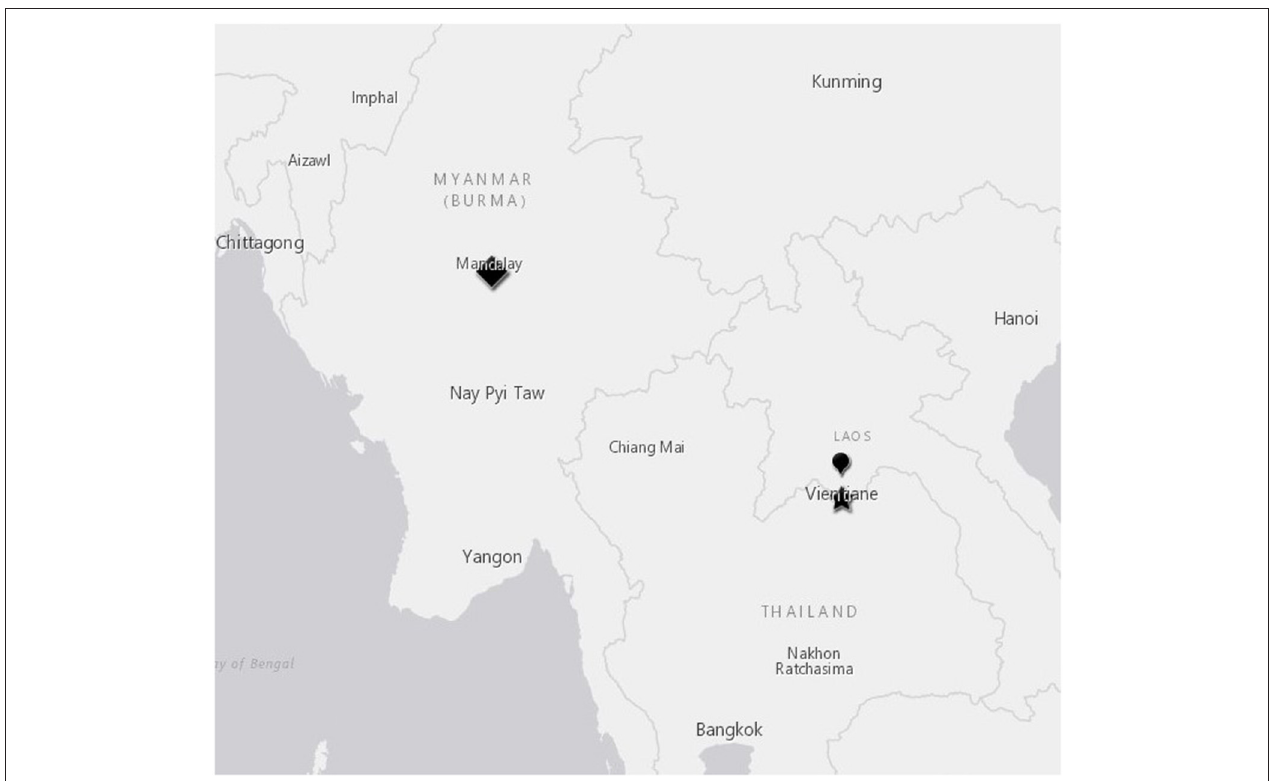
FIGURE 1 | Slaughterhouse locations in Mandalay, Myanmar and Vientiane, Laos. Mandalay slaughterhouse, diamond symbol; Dongdou slaughterhouse, star symbol; Nangduang slaughterhouse, balloon symbol.